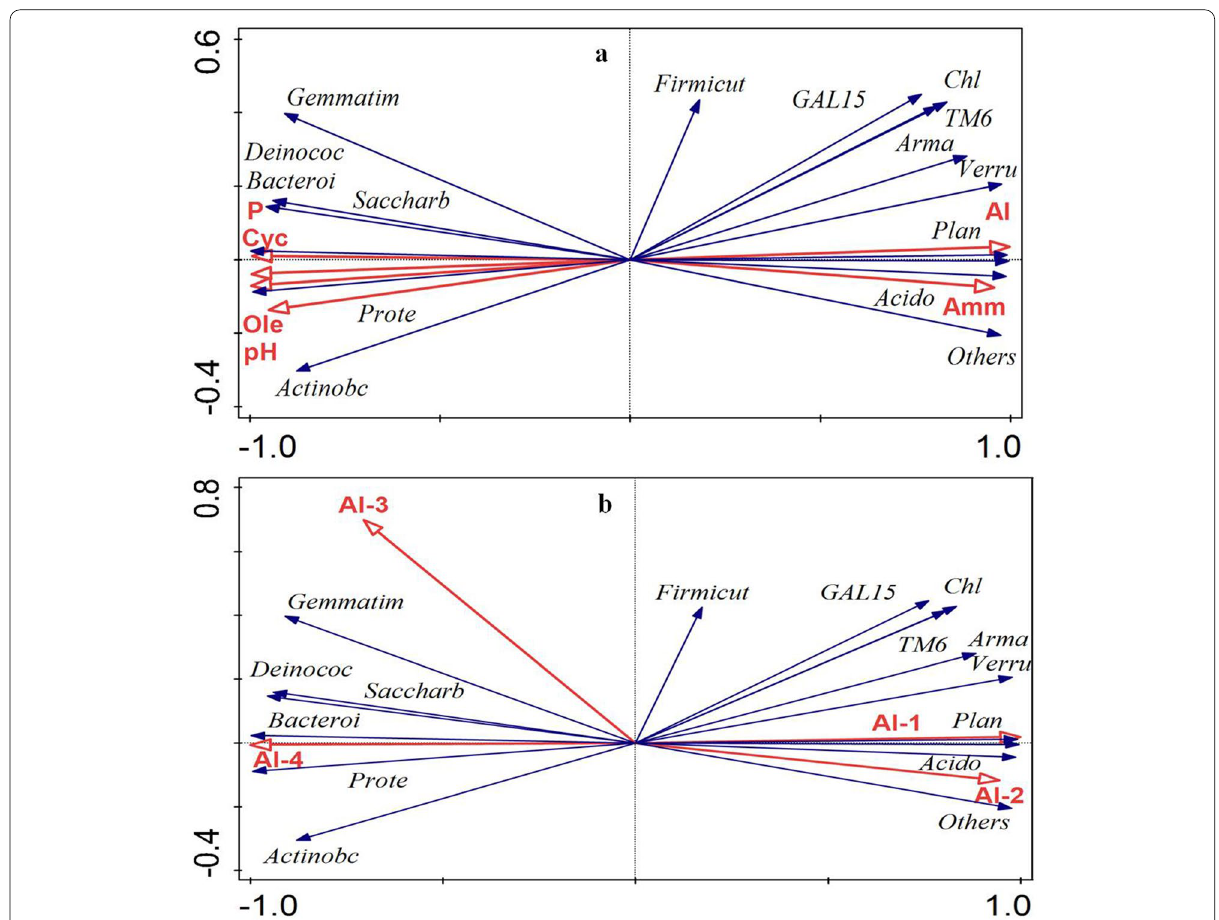
Fig. 5 Redundancy analysis of soil bacterial and environmental factors. Al, aluminum; P, phosphorus; Ole, oleamide; Cyc, cyclohexene; Bor, (